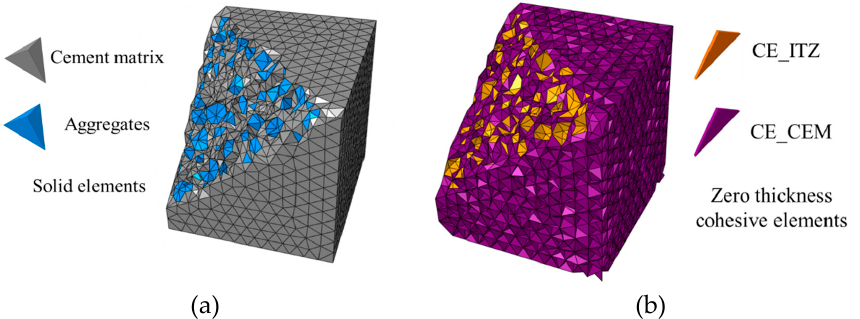
Figure 8. Mesh of the concrete specimen: ( a ) solid elements, ( b ) zero thickness cohesive elements.